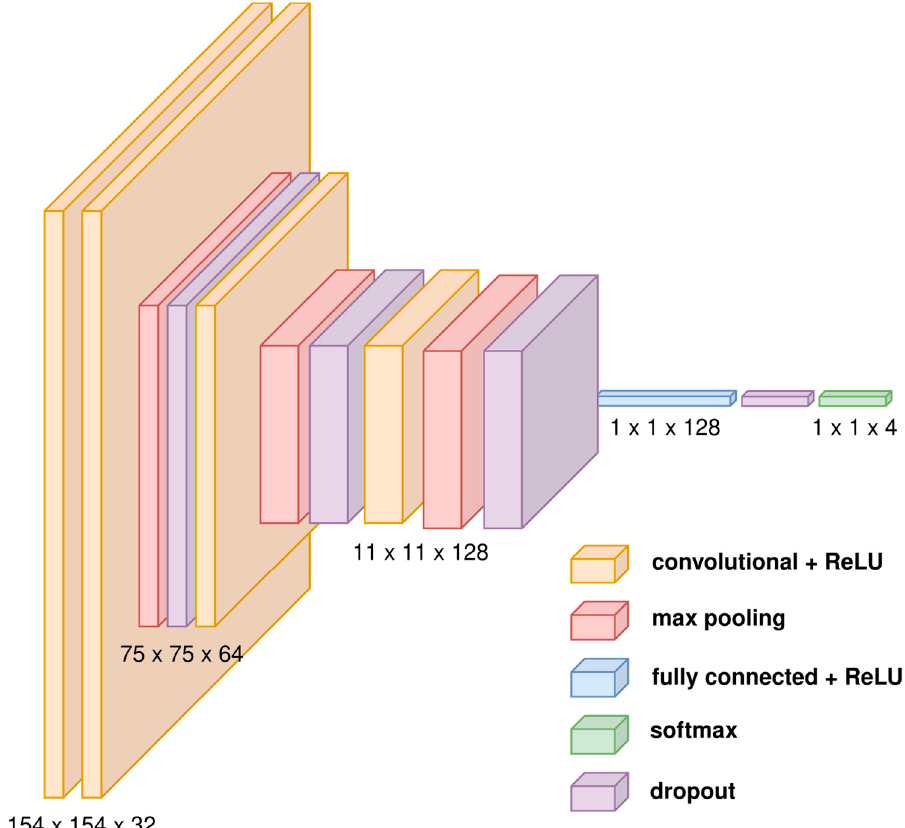
Figure A1. Visualization of the simple convolution model’s architecture.